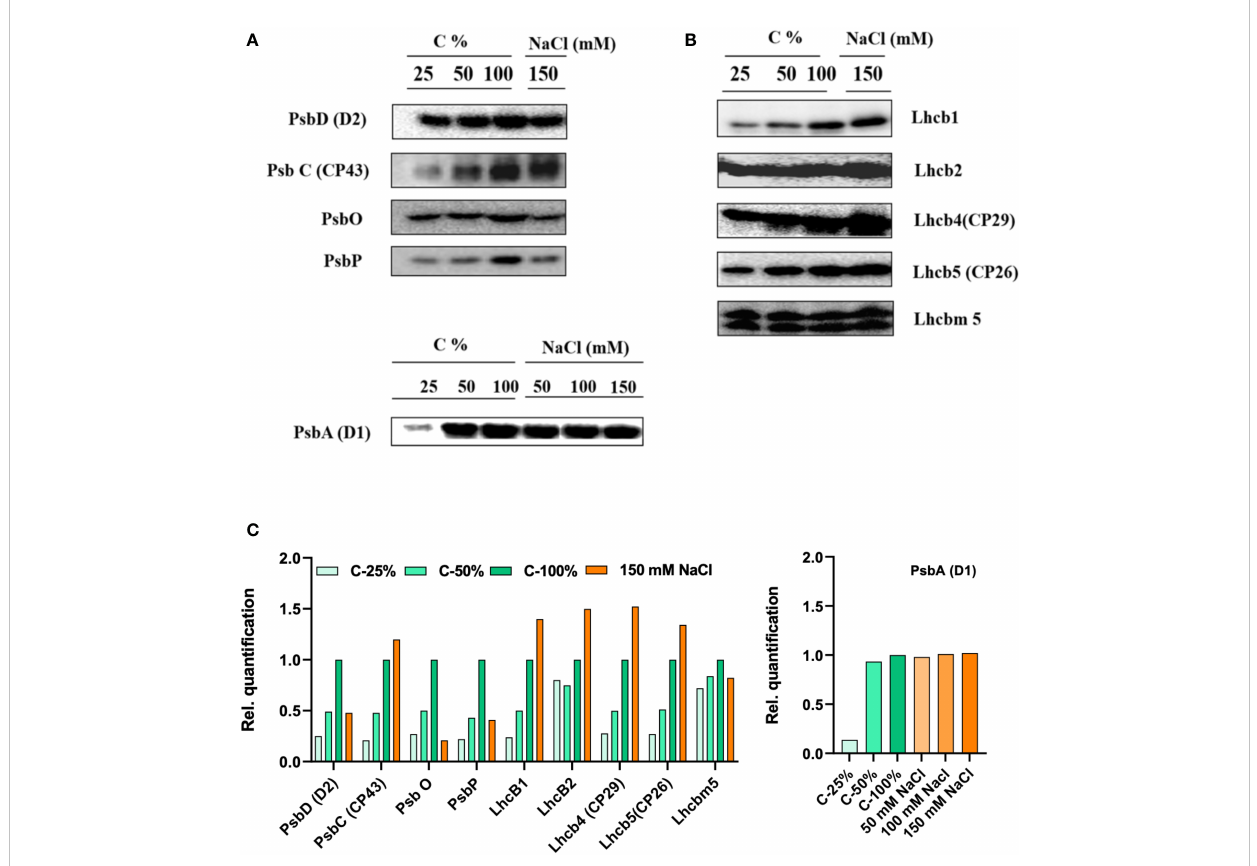
FIGURE 9 Protein pro fi le analysis of thylakoid membranes isolated from 0 and 150 mM sodium chloride (NaCl) grown C. reinhardtii cells, probed with (A) photosystem (PS)II core antibodies (PsbD — D2, PsbC — CP43, PsbO, and PsbP) and with (B) LHCII antibodies (Lhcb1, Lhcb2, Lhcb4, Lhcb5, and Lhcbm5) (C) the relative density of proteins were quanti fi ed using ImageJ software. In order to compare the loading control, the wild-type samples were loaded with different dilutions (25, 50, and